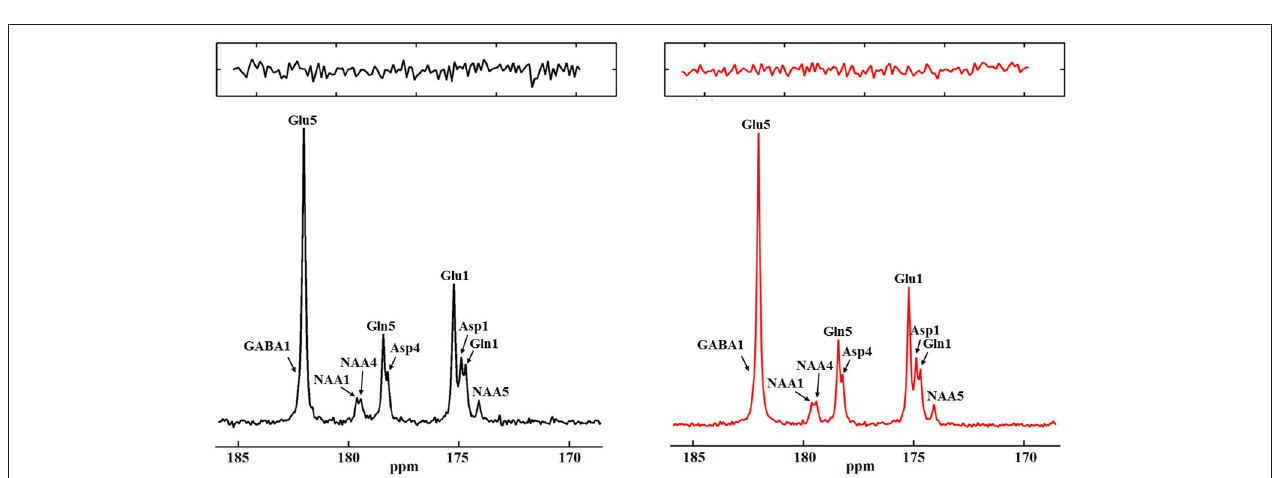
FIGURE 13 | Monte Carlo simulation results from fully (left) and under-sampled data (right) . Fully sampled spectra was averaged from 70 Monte Carlo simulations and under-sampled spectra was averaged from 100 Monte Carlo simulations with a 30% under-sampling rate. The total decoupling durations are the same for the fully sampled data and under-sampled data. Zoomed in noise insets for each spectra are displayed at top. The ratio of noise variances between the fully sampled and the under-sampled spectra is 2.16:1. Adapted from Li et al. [36].